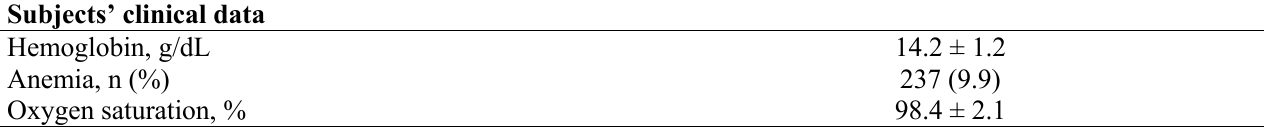
Table 2. Hemoglobin concentration, anemia status and oxygen saturation of the subjects (n = 2386) Subjects’ clinical data